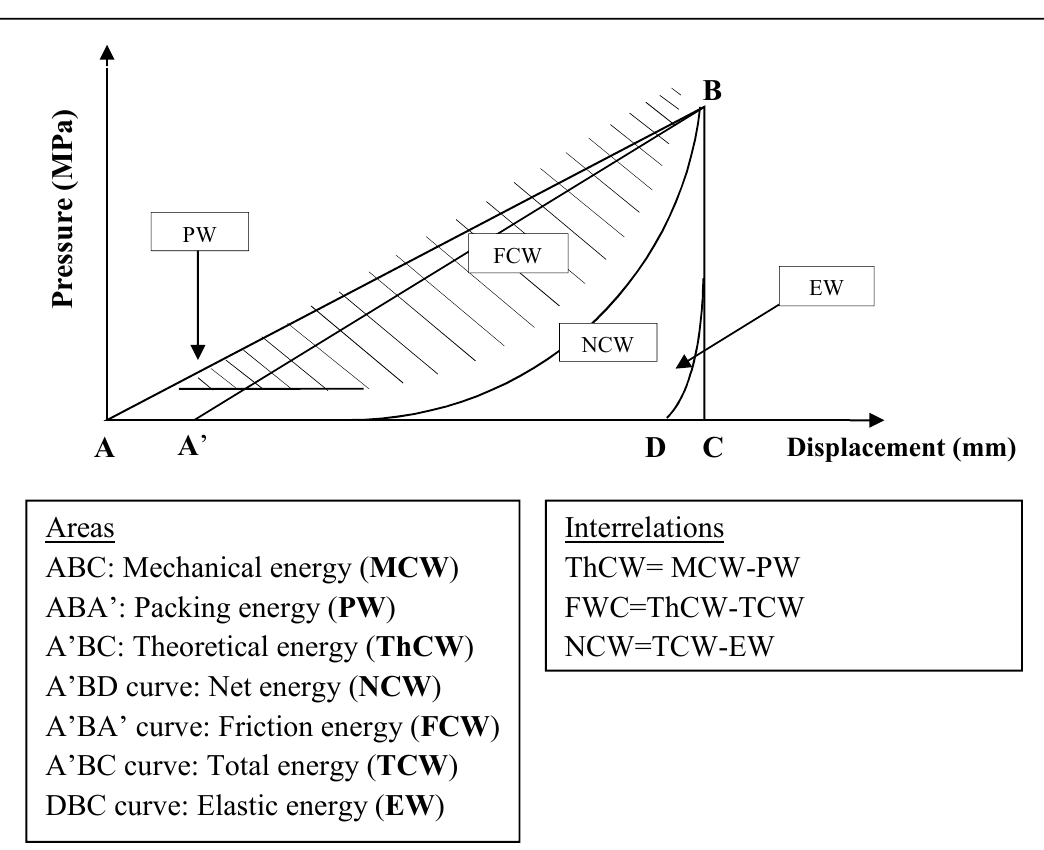
Table 1. Packing coefficient of the materials.